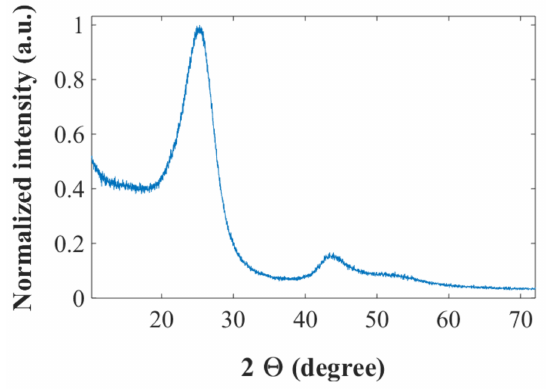
Figure 1. XRD spectrum for the Toho Tenax IMS65